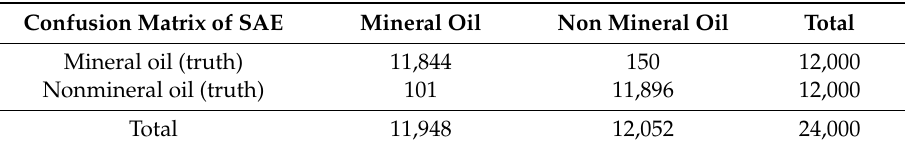
Table 7. Confusion Matrix (20,000 training, 4000 testing, six-fold) derived by SAE.